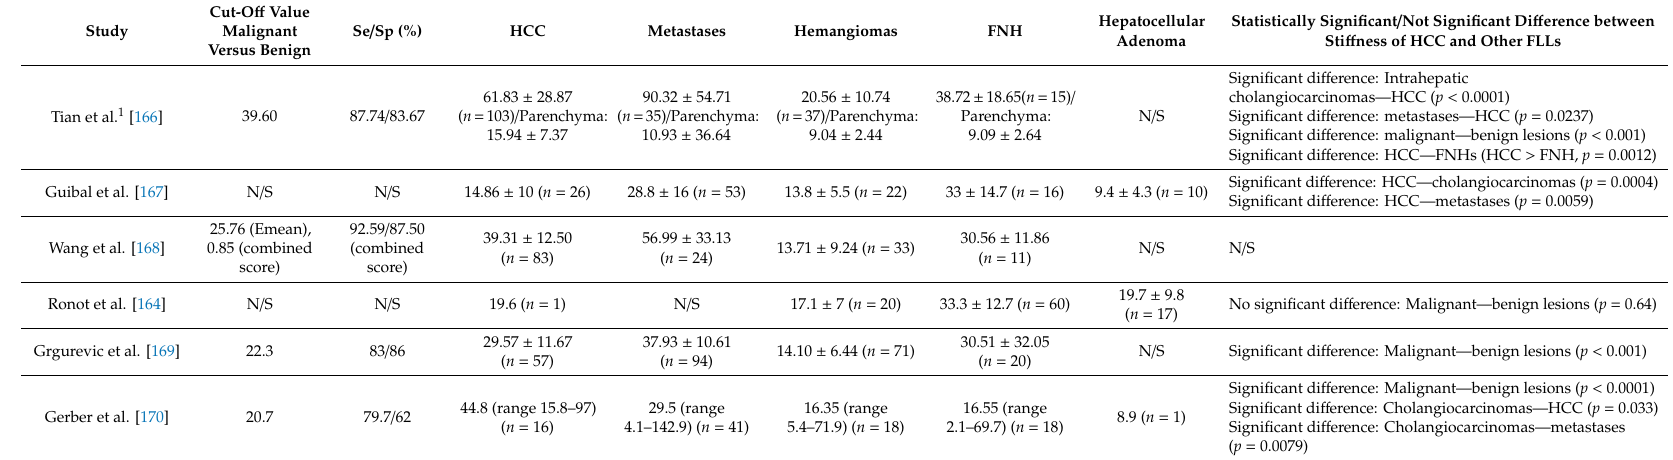
Table 6. Mean sti ff ness values (kPa) of FLLs measured by 2D-SWE with the associated cut-o ff values to di ff erentiate malignant FLLs from benign FLLs.